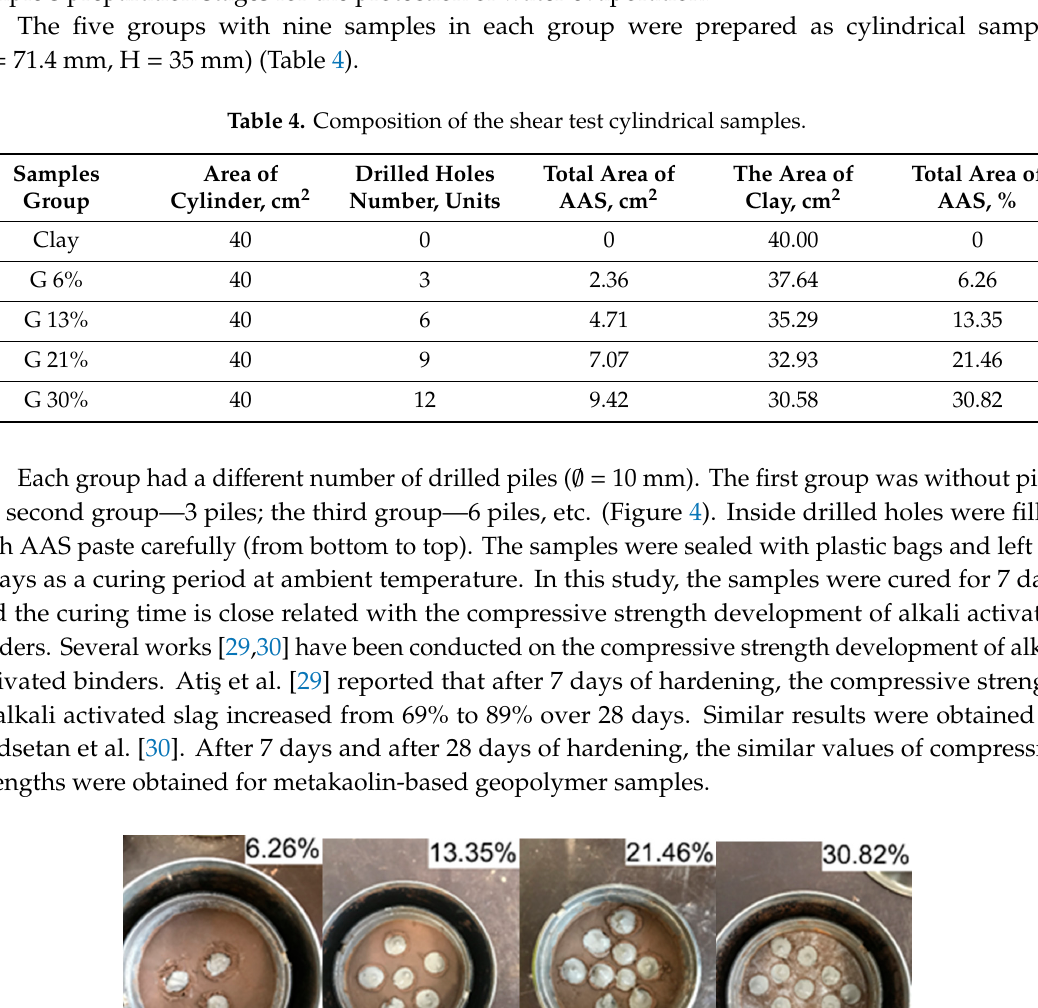
Table 4. Composition of the shear test cylindrical samples.